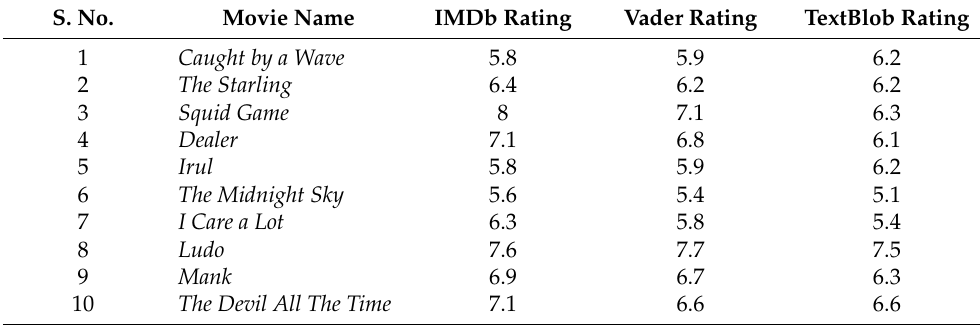
Table 6. Comparative analysis of predicted ratings of Vader and TextBlob with IMDb rating.